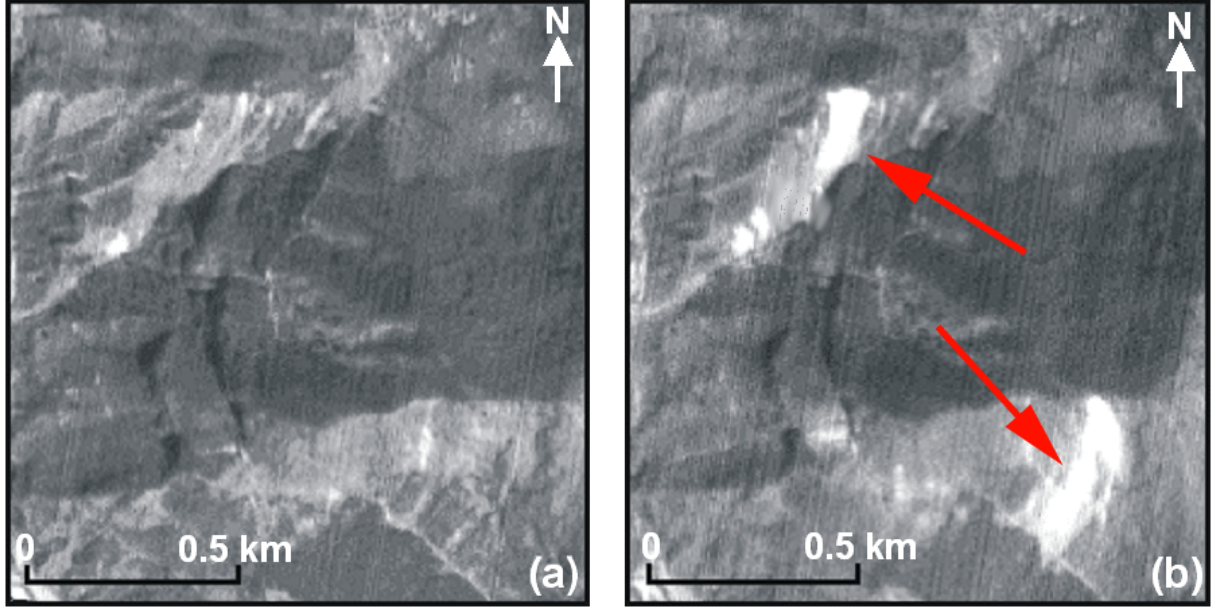
Figure 2. Surface deformations mapping for the Chamoli earthquake (M = 6.3, 29 March 1999 Himalaya, India). Change detection after the earthquake [11]. (a) IRS-1C-PAN pre-earthquake image of 26 March 1999. (b) IRS-1C-PAN post-earthquake image of 31 March